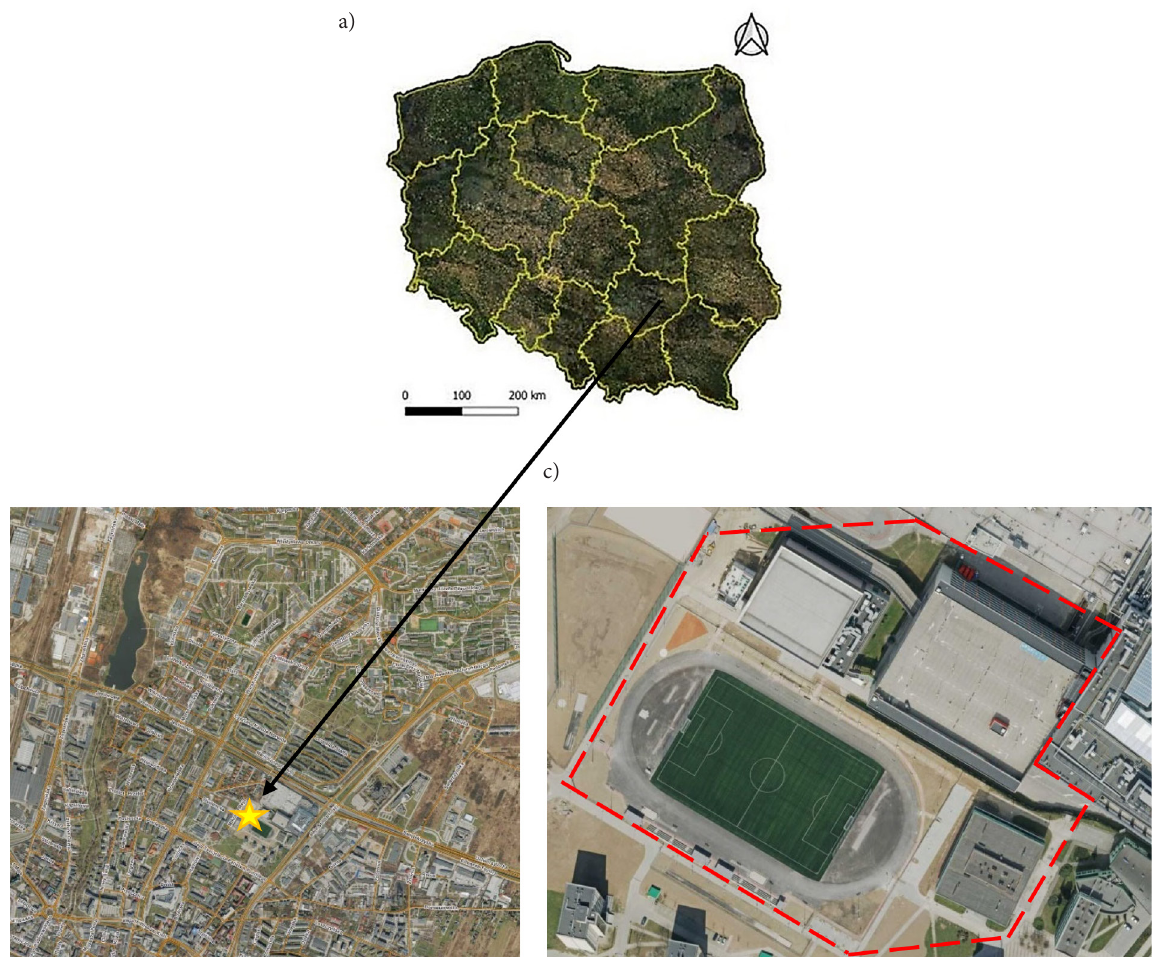
Figure 2. Location of the testing ground: a – approximate location against the background of Poland; b – general location of the athletics stadium in the eastern area of the city of Kielce, voivodeship Świętokrzyskie; c – detailed location of the training ground next to the Kielce University of Technology